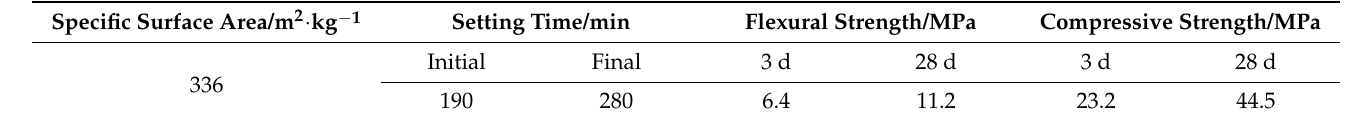
Table 1. Basic mechanical properties of Portland cement.